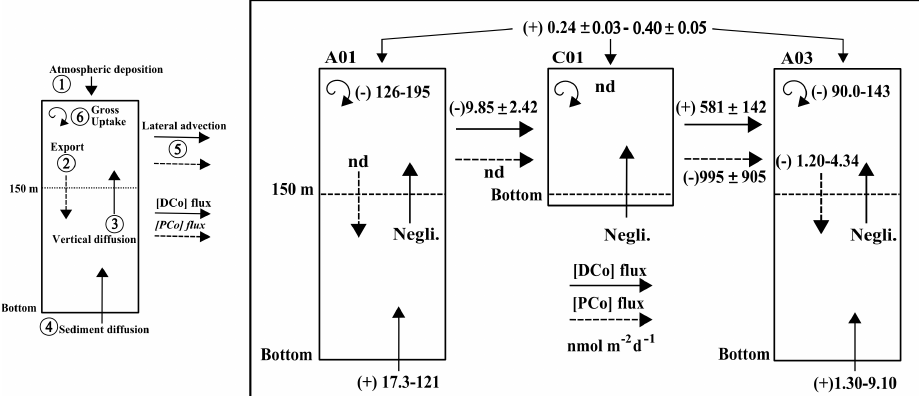
Fig. 4. Budget of dissolved cobalt (DCo) and particulate cobalt (PCo) over the shallow Kerguelen Plateau. All estimated fluxes are in nmolCom − 2 d − 1 , and based on an assumption of steady state. (1) Total atmospheric Co deposition flux on Kerguelen Island (A. Heimburger and R. Losno, personal communication, 2011). The downward PCo export flux (2) was estimated from PCo measured at A03. The vertical diffusion flux across the pycnocline (3) was negligible at A01 and A03 since there was no gradient of [DCo] within pycnocline. The sediment diffusion flux (4) was determined using the [DCo] gradient in the 20m above the bottom and Kz ranging from 1.0 10 − 4 to 7.0 10 − 4 m 2 s − 1 as determined in bottom waters of the Santa Monica Basin (Johnson et al., 1988). This flux could not been determined at C01 since no [DCo] gradient was observed above the sediment. The lateral advective flux in the top 150m (5) was estimated using the gradients of [DCo] and [PCo] between A01 and C01, and between C01 and A03 (only considering DCo inputs at A03) and using a mean current velocity of 4 . 0 ± 0 . 5cms − 1 (Park et al., 2008b). As sediments at C01 are mainly composed of coarse-grained basalts (Viollier et al., 2005), [PCo] at C01 was estimated from the average Co abundance in dredged basalts north of Heard Island of 69 . 2 ± 8 . 60ppm (standard error, n = 8) (Weis et al., 2002), and by using the particulate Nd concentration measured at C01 (141 . 3 ± 4 . 6pM at 20m depth; Jeandel et al., 2011) and a mean lithogenic Co/Nd ratio of 4 . 01 ± 2 . 40 (standard error, n = 8), representative of the basalts in the vicinity of Heard Island (Weis et al., 2002). The error bar was calculated by propagating the uncertainties of all variables. The gross uptake by diatoms (6) was estimated from recorded fucoxanthin concentrations (J. Ras and H. Claustre, personal communication, 2011) and the corresponding cobalt uptake rate reported by Saito et al. (2010). Note: “nd” means not determined; “Negli.” means negligible term.